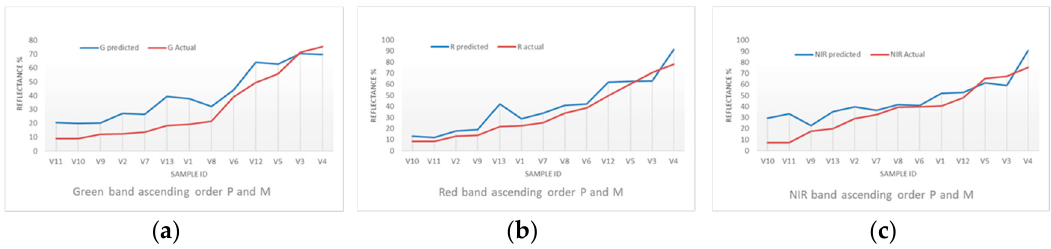
Figure 9. M (red line) and P reflectance plots for G ( a ); R ( b ) and NIR ( c ) bands from EL2 Dulux .